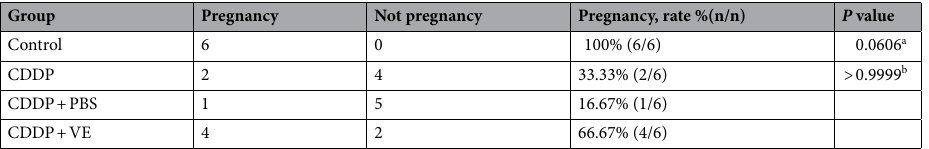
Table 1. Effects of CDDP and VE on pregnancy rates in rats. Pregnancy rate = total number of pregnancy/total number of matings. a Control group versus CDDP group. b CDDP + VE group versus CDDP group. P values were statistically calculated using Fisher’s exact